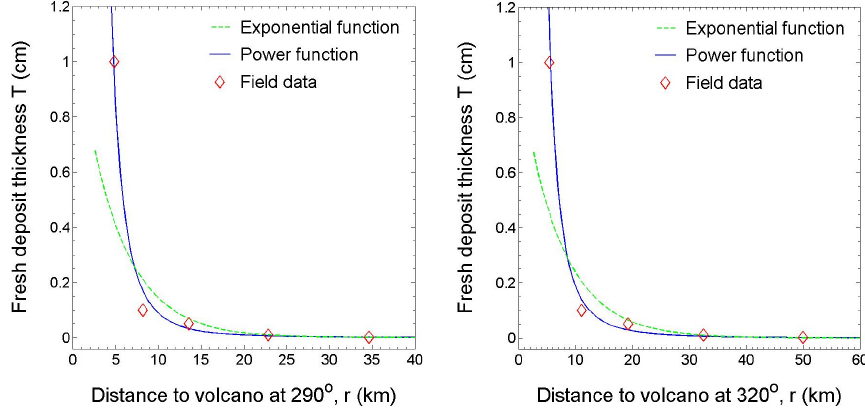
Fig. 4. Ashfall deposit thickness data for the 21 December 1994 Popocat´epetl eruption. Field data (diamonds obtained from the isopachs of Martin Del Pozzo, 1995), and best fittings to the power function (solid line), and to the exponential function (dashed line). (a) Thickness values and best fits along a radial line at 290 ◦ (counterclockwise) respect to the wind axis (solid line, C r =− 0 . 983; dashed line C r =− 0 . 973). (b) Same as in (a), but along a radial line at 320 ◦ respect to the wind axis (solid line C r =− 0 . 981; dashed line C r =− 0 . 977).